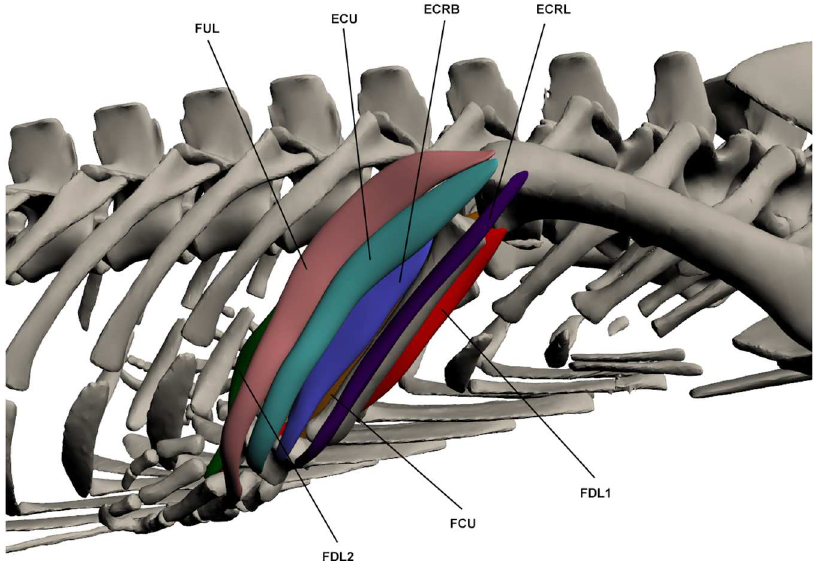
Fig 10. Intrinsic muscles of the forelimb: wrist extensors/flexors. FUL: Flexor ulnaris longus ,ECU: Extensor carpi ulnaris ,ECRB: Extensor carpi radialisbrevis , ECRL: Extensor carpi radialislongus , FDL1-2: Flexor digitorumlongus ,FCU: Flexor carpi ulnaris